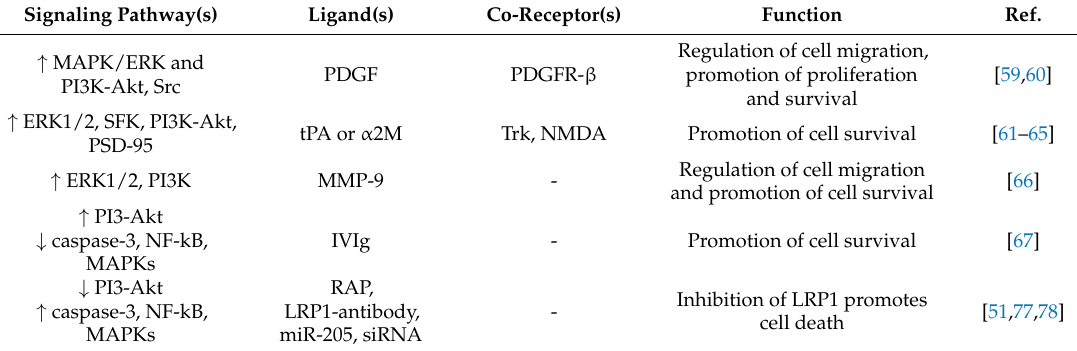
Table 1. Lipoprotein receptor-related protein 1 (LRP1)-mediated pro-survival signaling pathways. Signaling